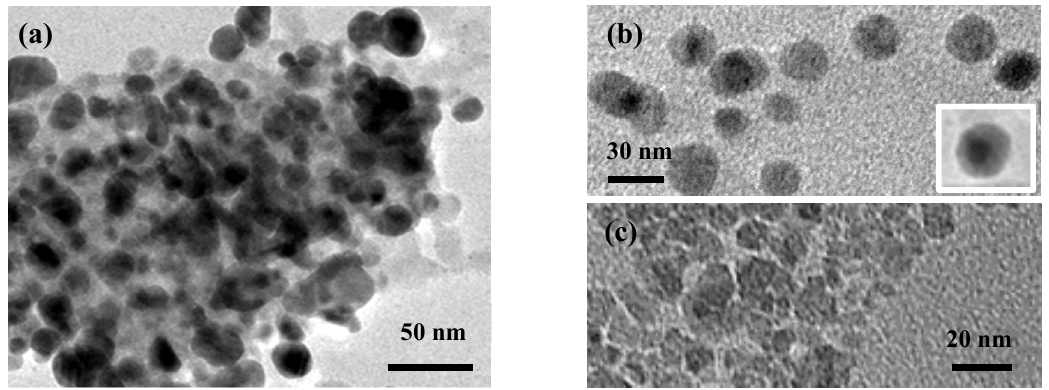
Figure 3. Transmission electron microscopy (TEM) images of: ( a ) and ( b ) Ag@ α -Fe 2 O 3 composite; ( c ) α -Fe 2 O 3